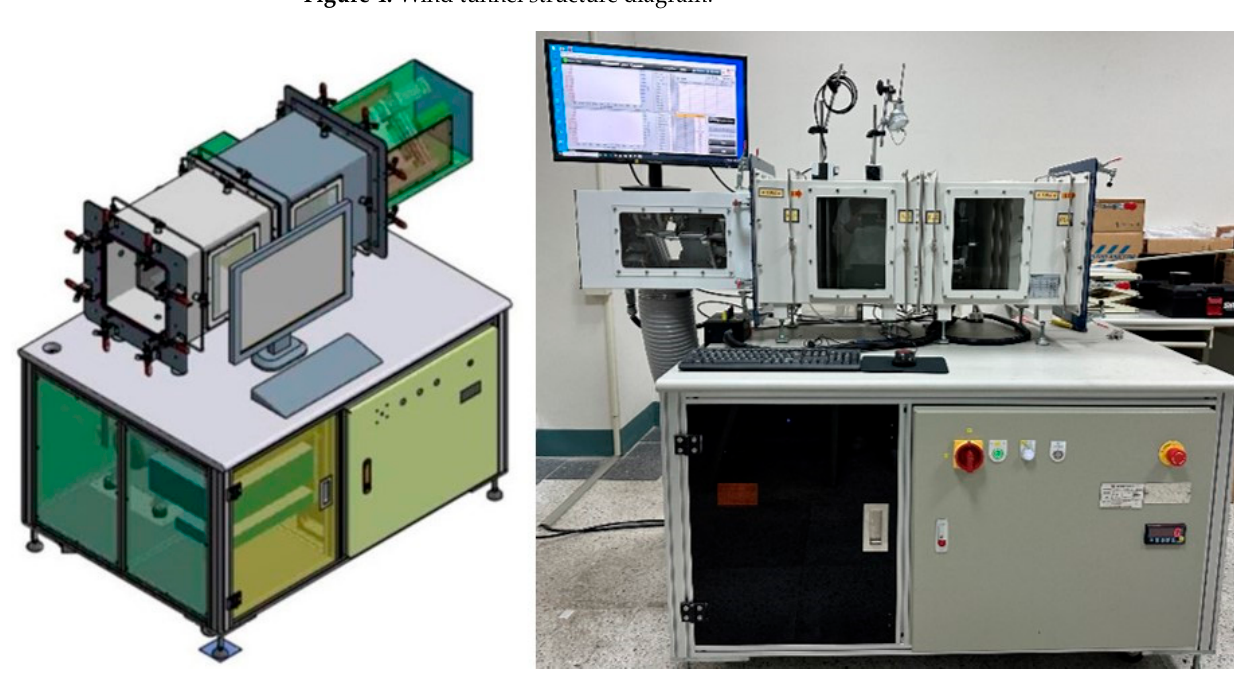
Figure 5. Fan performance measurement system SW-300 [38].